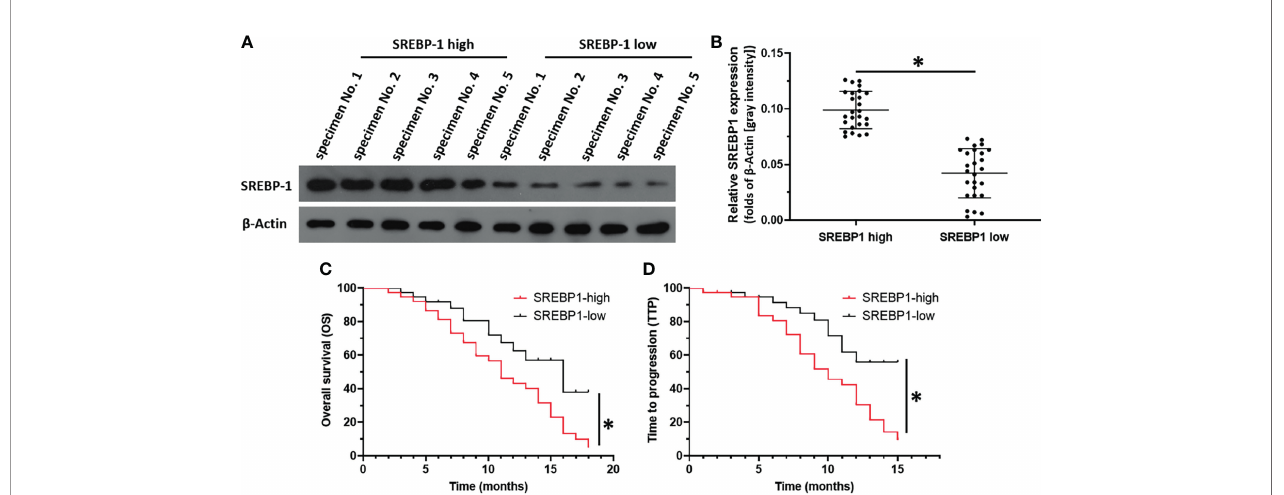
FIGURE 1 | The correlation between SREBP-1 ’ s expression with the prognosis of HCC patients post RFA. HCC tumor tissue obtained by coaxial puncture, using WB to detect the expression level of SREBP-1 in the tissue. (A) Representative images of WB results of 5 patients in the high expression group and 5 patients in the low expression group. (B) The results of WB were quantitatively analyzed by Image J software, and the relative expression level was calculated with the result of one of the specimens as unit 1. Divide patients into two groups based on the median relative expression level (SREBP-1 high group; SREBP-1 low group). (C, D) For SREBP-1 high group and SREBP-1 low group patients, combined with clinical data for survival analysis to determine the patient ’ s OS and TTP. *P <